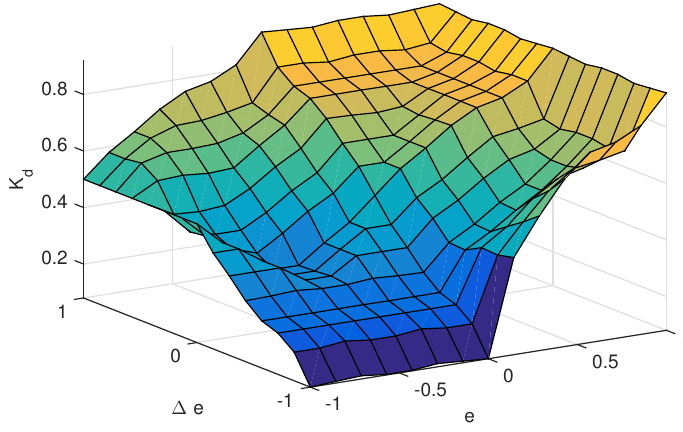
Figure 11. Fuzzy surface for K d gain.